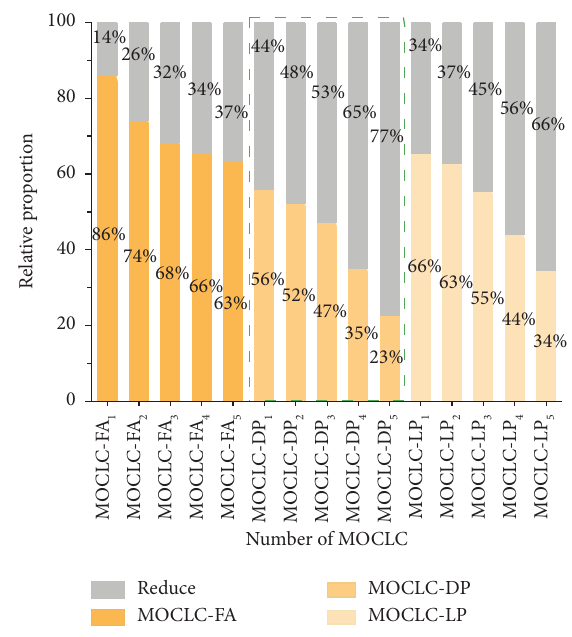
Figure 5: Efect of mineral admixture with diferent types and contents on splitting strength of